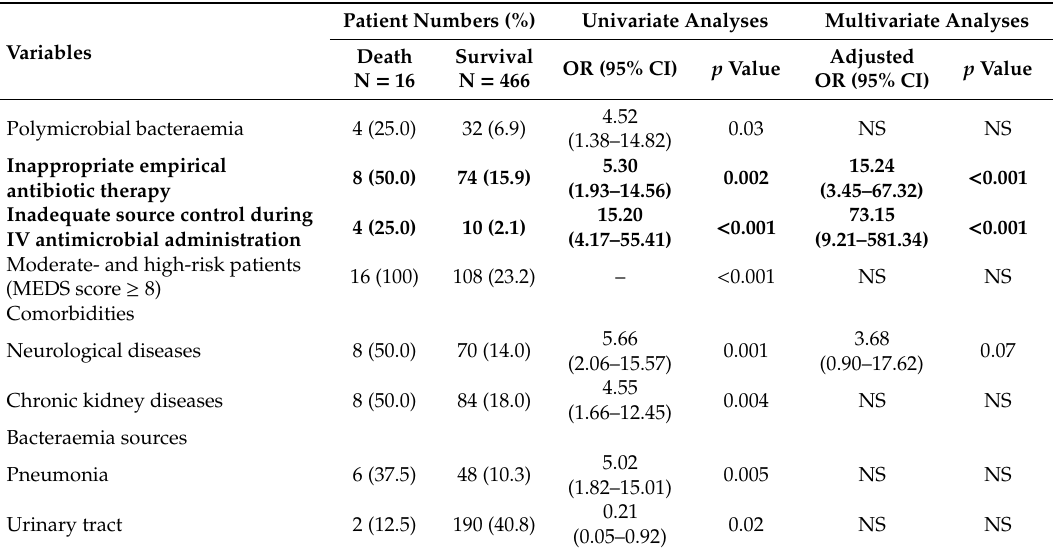
Table 4. Predictors of post-switch 30-day mortality in 482 patients who received early IV-to-PO switch. Patient Numbers Variables